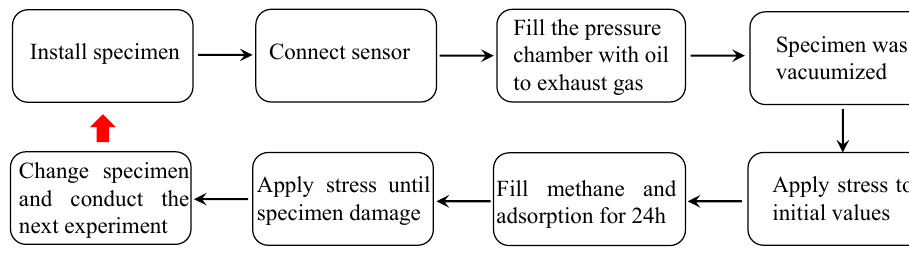
Figure 4. Flow chart for the experiment.